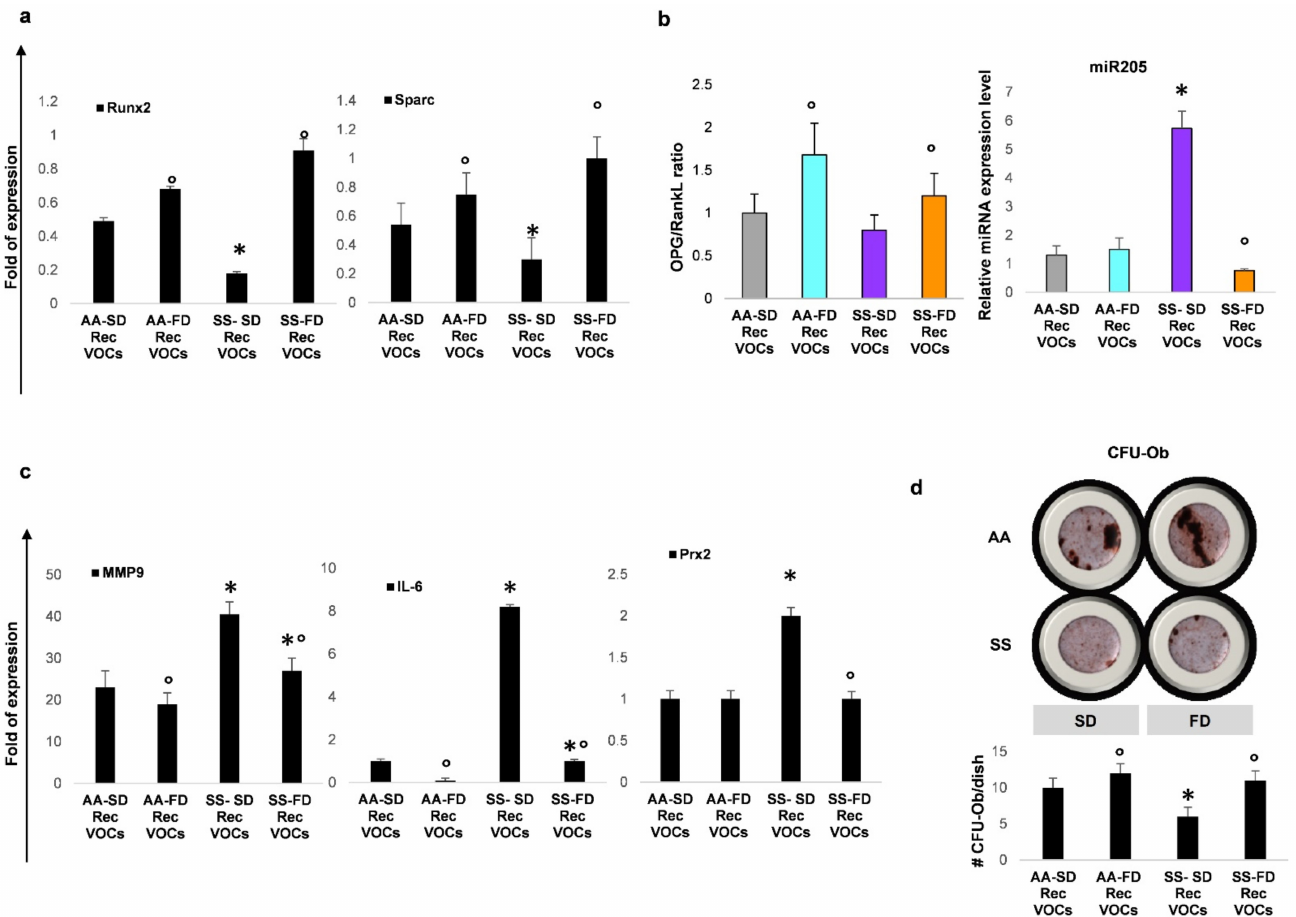
Figure 3. In SCD mice, FD diet beneficially affects osteoblastogenesis and osteogenic commitment. ( a ) Real-time PCR analysis of Runx2 and Sparc gene expression in bone from SD/FD AA and FD SS mice exposed to recurrent H/R (rec H/R). ( b ) Left panel . Osteoprogerin (OPG)/RANKL ratio in SD/FD AA and FD SS mice exposed to recurrent H/R (rec H/R). Right panel . Bone miR205 expression was downregulated in FD SS mice exposed to rec H/R compared to SD SS animals. ( c ) Real-time PCR analysis of bone interleukin-6 (IL6), matrix metalloproteinase 9 (MMP9) and peroxiredoxin-2 (Prx2) gene expression was reduced in FD SS compared to SD SS mice exposed to recurrent H/R. ( d ) To assess the number of osteoprogenitors, bone marrow derived cells were cultured in vitro under osteogenic differentiation condition. The CFU-Ob obtained from mesenchymal stem cells of AA and SS mouse groups were stained with alizarin red ( upper panel ) and quantified ( lower panel ). By comparing the number of CFU-Ob (colony forming unit-osteoblastic), we observed an increased number of CFU-Ob in FD fed mice, which is in agreement with the increased osteogenic commitment of progenitor cells. ( a – c ) Data are shown as mean ± standard deviation (SD) ( n = 4; 2 females and 2 males). * p < 0.05 compared to AA; ◦ p < 0.05 compared to SD. ( d ) Data are shown as mean ± standard deviation (SD); at least six independent experiments have been performed; * p < 0.05 compared to AA; ◦ p < 0.05 compared to